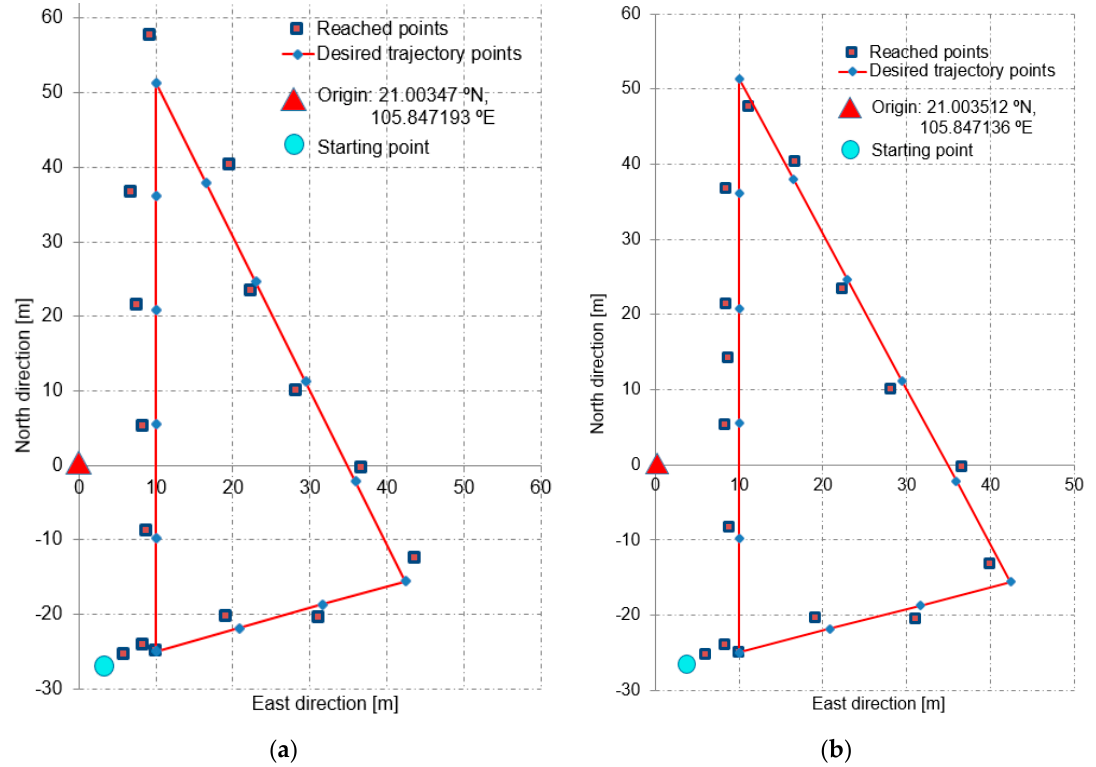
Figure 11. The AUV reached and followed a desired triangle-shaped trajectory: ( a ) with the EKF algorithm; ( b ) with the UKF algorithm.